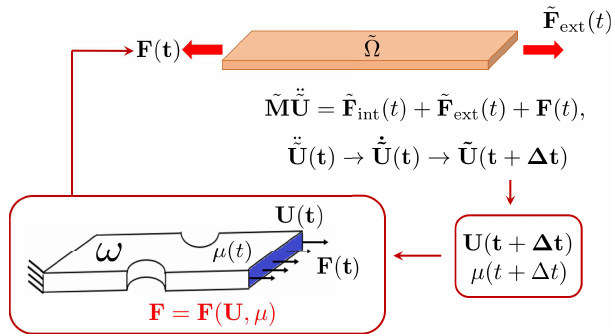
Fig. 7. Global-local time